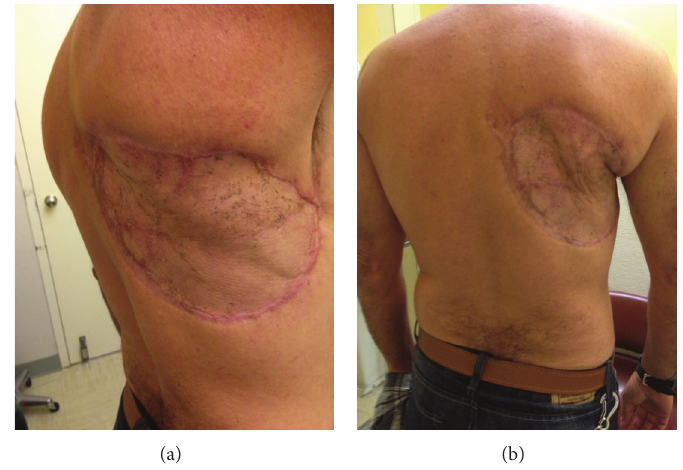
Figure 4: Postoperative visit status postsplit-thickness skin